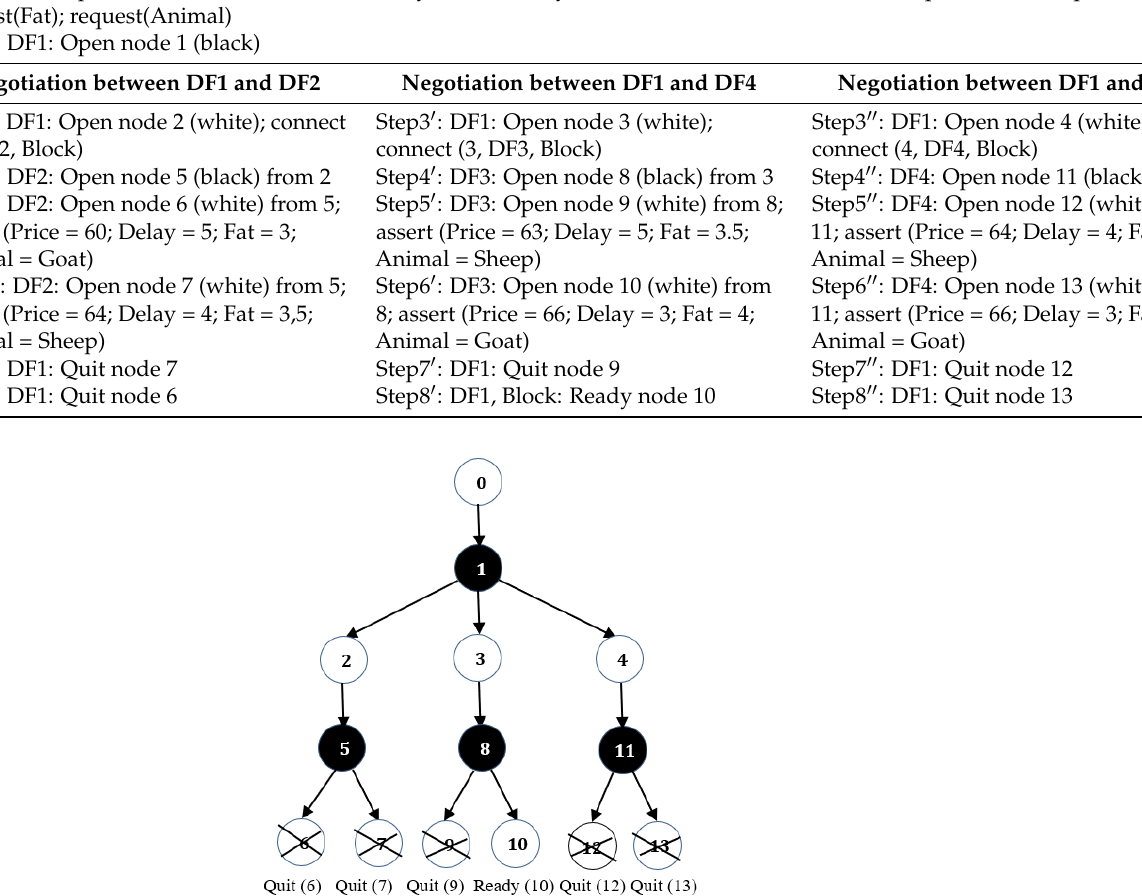
( c ) Figure 11. Negotiation graphs for the three guests: ( a ) DF2, ( b ) DF4, and ( c ) DF6. This example shows how three parallel negotiations can be managed by the proposed negotiation infrastructure. Therefore, at the middleware level, the negotiation interactions correspond to the creation in the negotiation graph of three white nodes (i.e., nodes 2, 3, and 4) managed by the Outsrc component of DF1 (Figure 10). Further, these interactions are propagated as the creation of a white node in each negotiation graph managed by the Insrc component of each guest, DF2, DF4, and DF6 (Figure 11). The three guests have their own (partial) copy of the complete negotiation graph but no information about each other in the negotiation process. The negotiation process is described below: ●